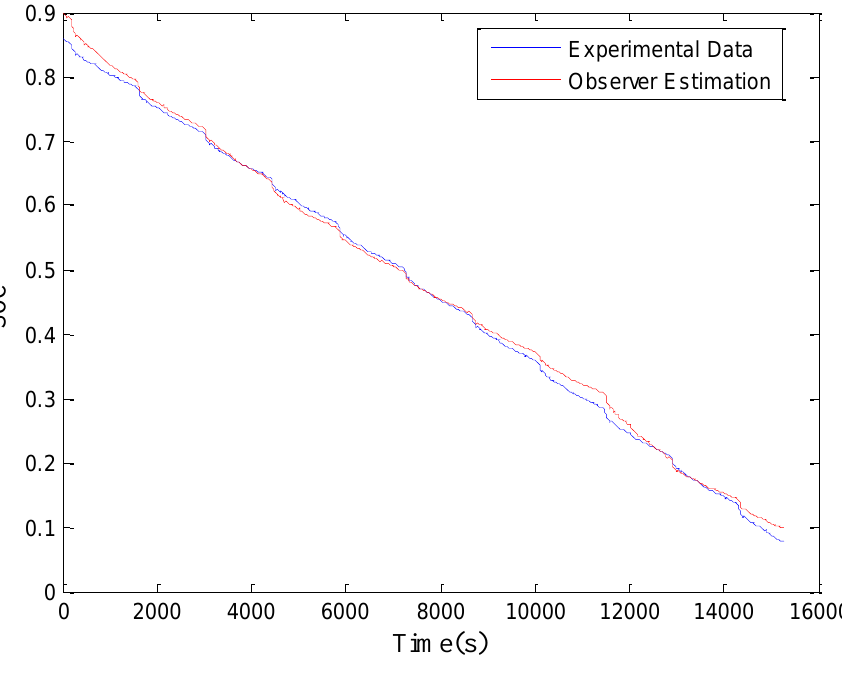
Figure 19. SoC estimation